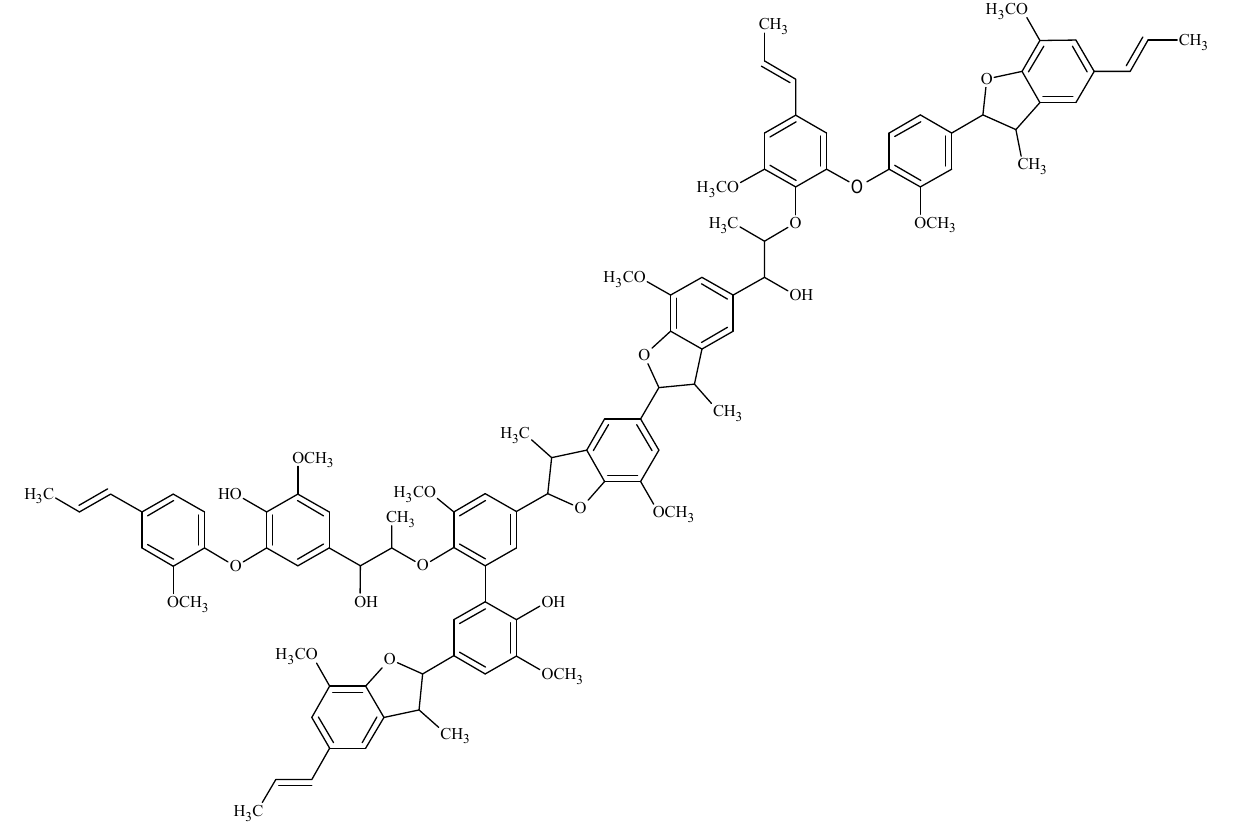
Figure 6. Representative “lignin-like” product of isoeugenol